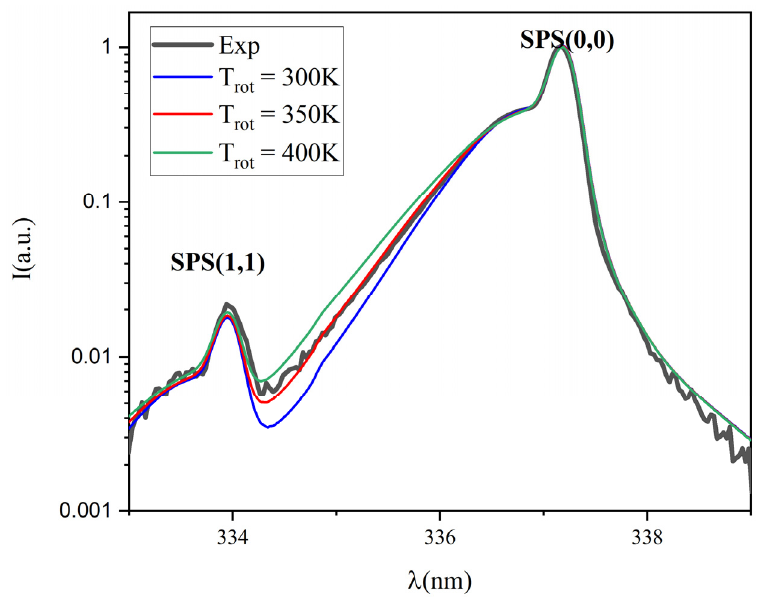
Figure 4. SPS (0,0) band emission (solid line) and simulated band profile for three different temperatures.